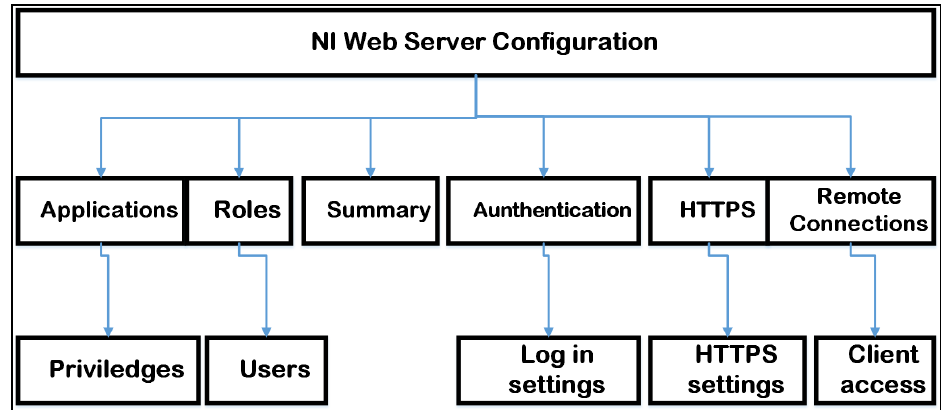
Figure 8. Server Configuration Wizard Aspects.